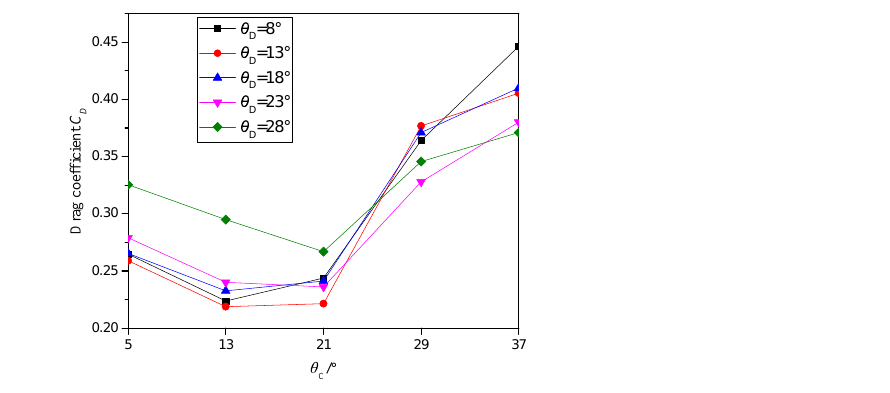
Figure 6. Variation of drag coefficient around AUH versus different design parameters θ C and θ D . It can be found in Figure 6 that drag coefficient C D decreases with the increase of θ C when this angle is smaller than a certain angle around 21 ◦ . It increases dispersedly with various θ D s when θ C is greater than that angle. The same trend is observed for every θ D series, and it can be more clearly illustrated for a series with the same θ D , such as θ D = 13 ◦ shown in Figure 7. With a smaller θ C (as 5 ◦ shown in Figure 7a), a more rounded leading corner at AUH’s front is formed, which produces a low pressure area near the design point C at the leading edge. The same situation occurs near the design point D with a greater θ C (as 29 ◦ shown in Figure 7d). This additional induced low pressure area increases AUH’s drag significantly, and it almost completely dissipates at θ C = 13 ◦ and 21 ◦ (as shown in Figure 7b,c). Therefore, V-shaped variation trend of drag coefficient for a series of θ D is induced by varying low pressure area. The descent at left side is controlled by that near the design point C , while the ascent at its right side is controlled by that near the design point D .